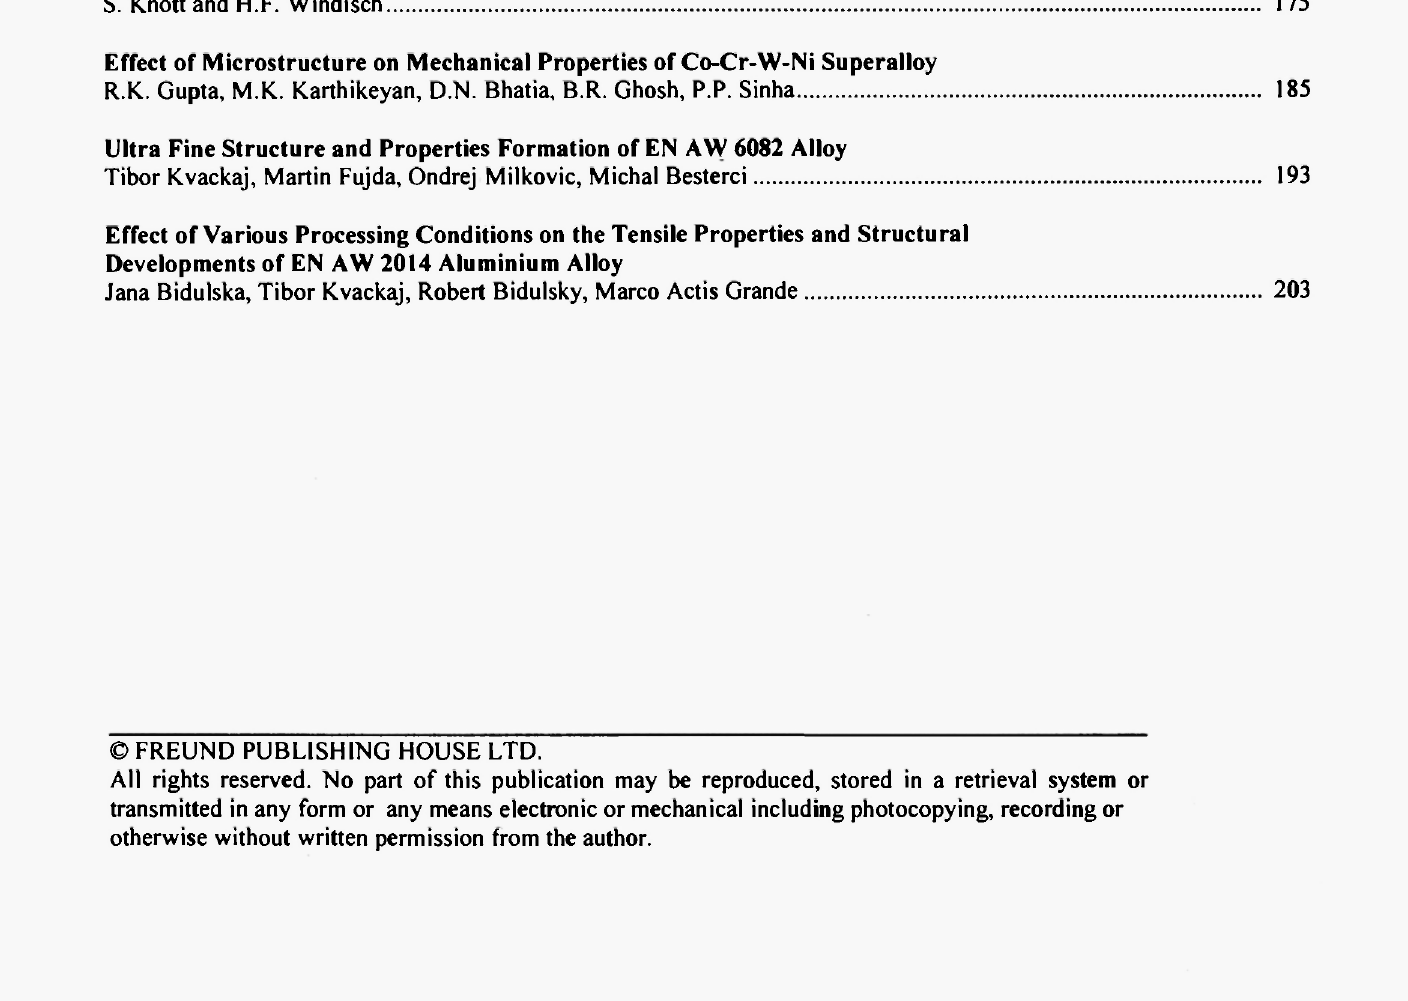
Analysis of the Specific Heat for the Transitions of the Phases I-ll-lII-IV in (NiCHj^CuCl, Crystal